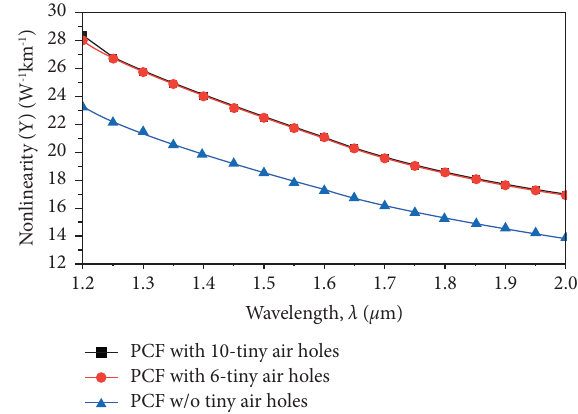
Figure 11: Efects of nonlinear coefcients for variation in wavelengths for the diferent PCF structures at a constant air hole � 1.5 μ m and a pitch of Λ � 2.2 µ m. size of d 0